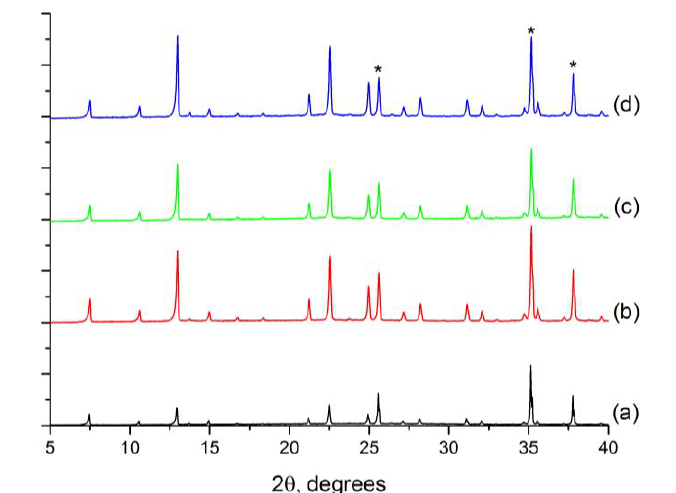
Figure 7. X-ray diffraction patterns of ITQ-29 materials grown on the alumina supports prepared at different crystallization times: ( a ) 3 days; ( b ) 7 days; ( c ) 10 days; ( d ) 14 days. *: alumina peaks from the support.